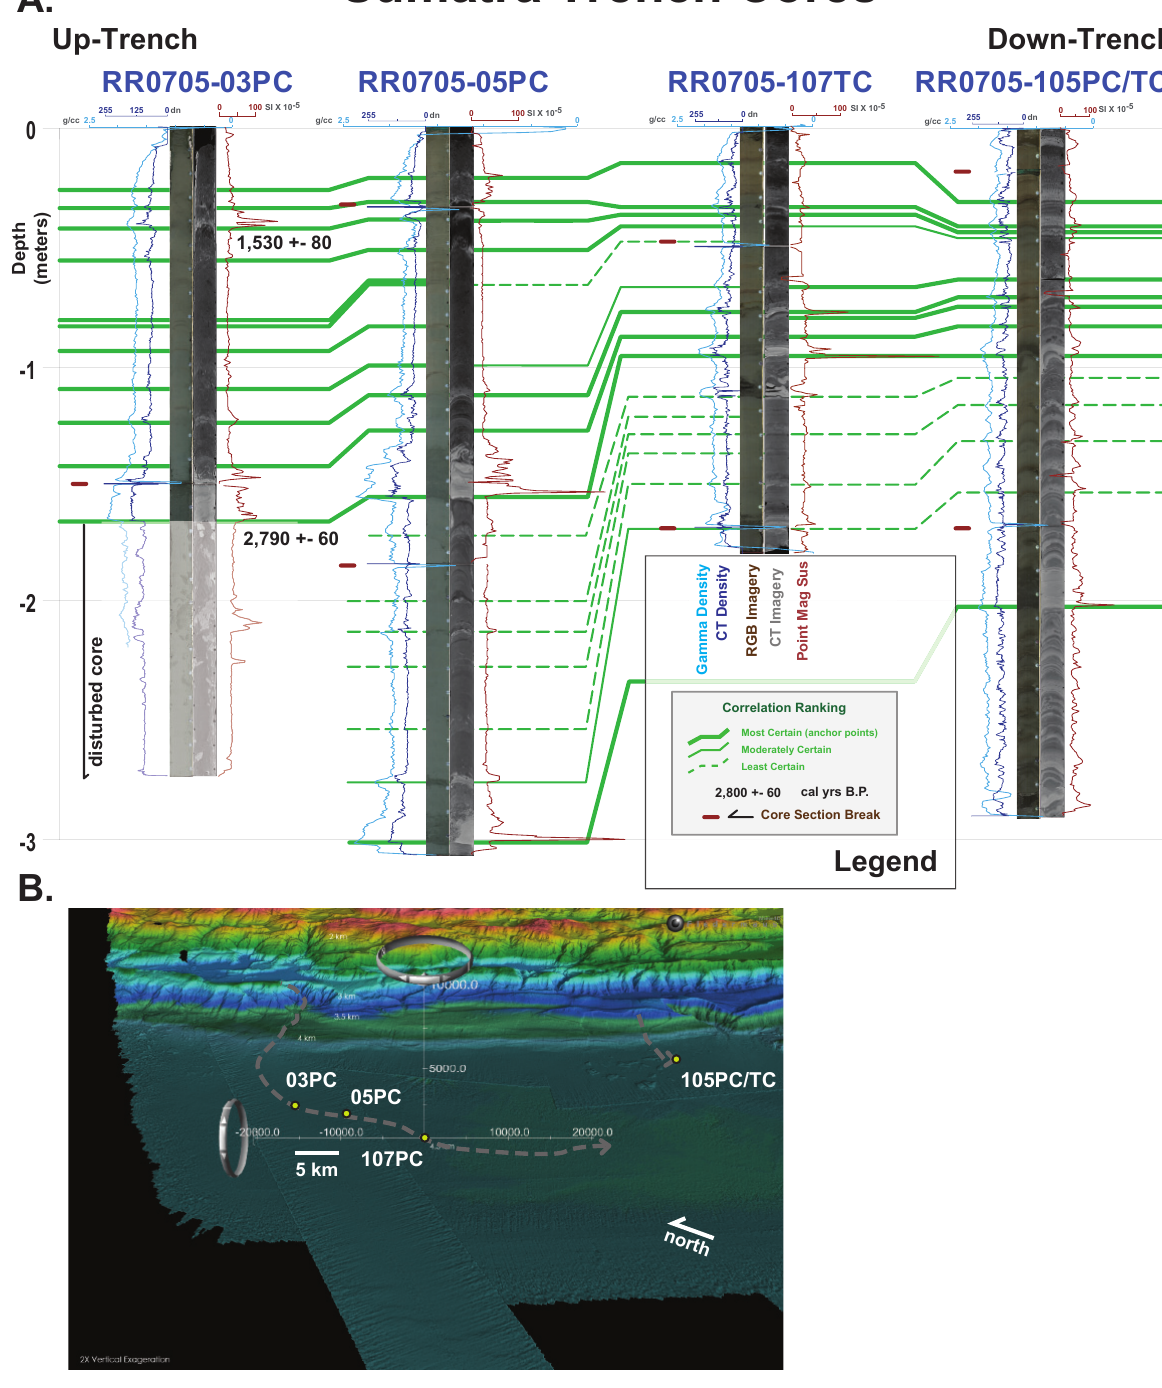
Fig. 8. Sumatra trench cores RR0705-03PC, RR0705-05PC, RR0705-107TC and RR0705-105PC/TC (Fig. 3). (A) Cores are plotted in same configuration as Fig. 2. Radiocarbon ages are displayed with 95% error. These ages are from below correlated turbidites in the slope core 108PC/TC (Table S1). (B) Low angle oblique view of core sites. Flow pathway from landslide source area to core sites is designated by a grey dashed line. Cores sites are plotted as yellow